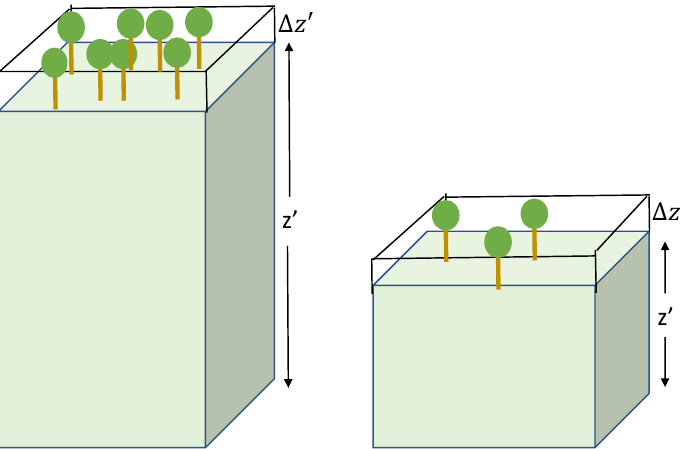
Figure 8. Schematic illustration of two stands with an increment of ∆ z (cid:48) in top height. The number of tree icons represents vegetation and consequent mass density in the stand near the physical top height z (cid:48) . The same change in top height, ∆ z (cid:48) , will produce less AGB change in the shorter plot on the right than in the taller one on the